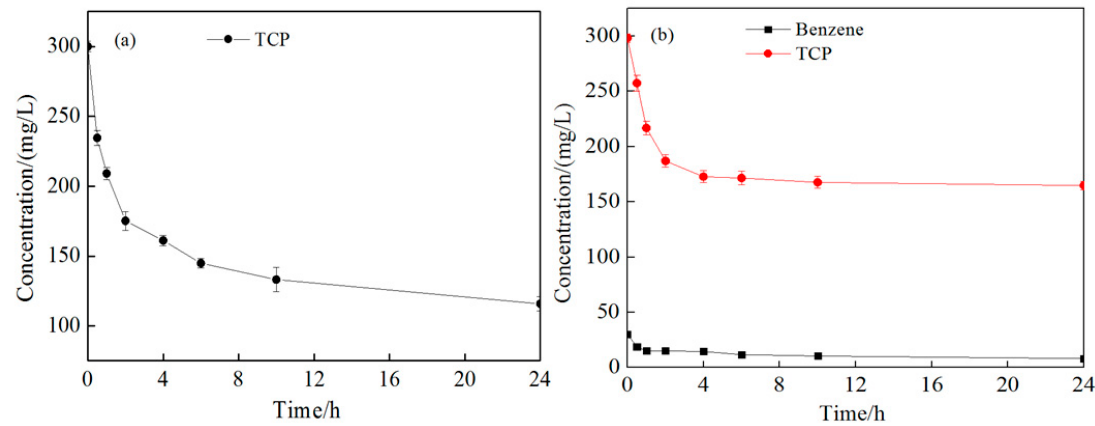
Figure 3. Changes of 1,2,3-trichloropropane (TCP) and benzene concentration in deionized water. Conditions: ( a ) The experiment was conducted with single contaminate of 280.64 mg/L TCP, 9.69 g/L persulfate, 20:5:1 molar ratio of S 2 O 82 − , Fe 2+ , and citric acid at ambient temperature; ( b ) the experiment was conducted with mixed contaminates of 296.31 mg/L TCP and 28.32 mg/L benzene, 9.69 g/L persulfate, 20:5:1 molar ratio of S 2 O 82 − , Fe 2+ , and citric acid at ambient temperature.